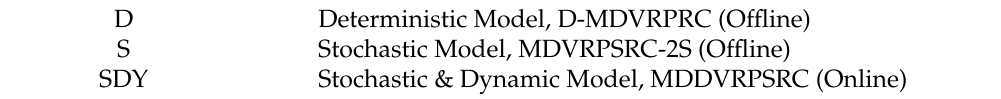
Table 14. Abbreviation for Tables and